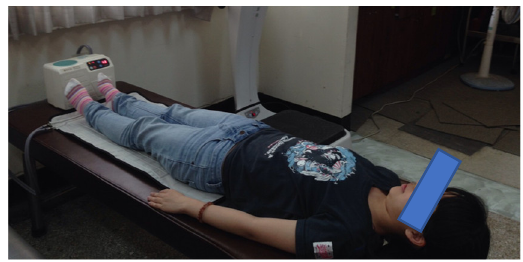
Figure 2. A heating pad warming a participant’s lower extremities.